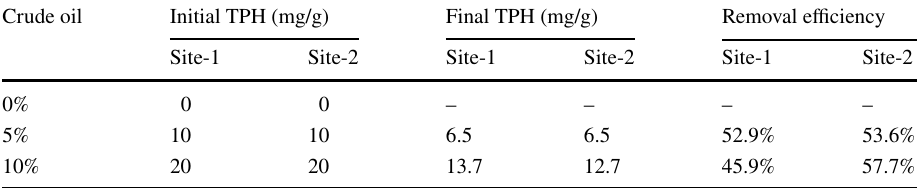
Table 5 TPH analysis of soil